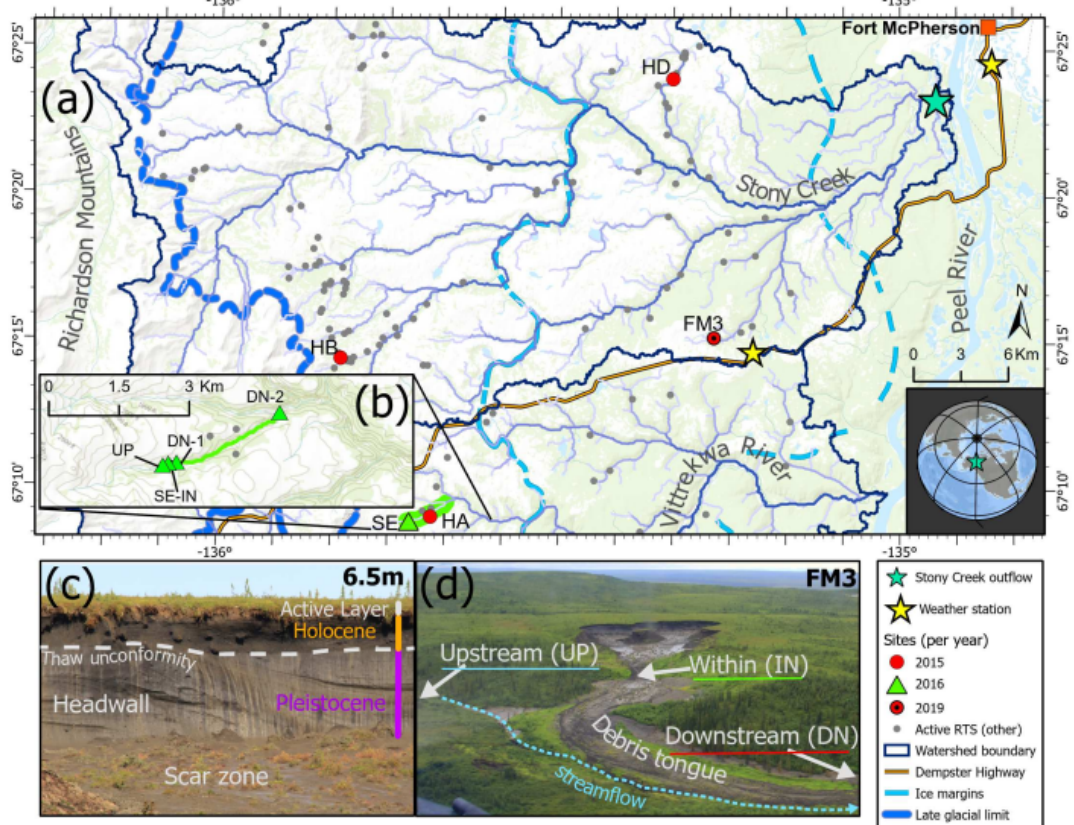
Figure 1. (a) Location of slump sites sampled for experiments. (b) 2016 sampling points (green triangles) show sampling locations along a transect which began just upstream of the point where slump SE runoff enters a valley bottom stream. Panel (c) shows headwall units of a slump. Panel (d) shows stream sampling points relative to a slump site, as sampling design used in the 2015 experiment. HA, HB, HD, SE, and FM3 are slump site IDs. Active RTS (retrogressive thaw slump) features are from Segal et al. (2016). Former glacial limits of the Laurentide Ice Sheet (ice margins and late-glacial limit) are delineated from Duk-Rodkin and Hughes (1992). Service layer credits: (1) world topographic map: Northwest Territories, ESRI, © OpenStreetMap contributors 2020, HERE, Garmin, USGS, NGA, EPA, USDA, NPS, AAFC, NRCan. Distributed under the Open Data Commons Open Database License (ODbL) v 1.0. (2) World ocean base: Esri, Garmin, GEBCO, NOAA NGDC, and other contributors. (3) World